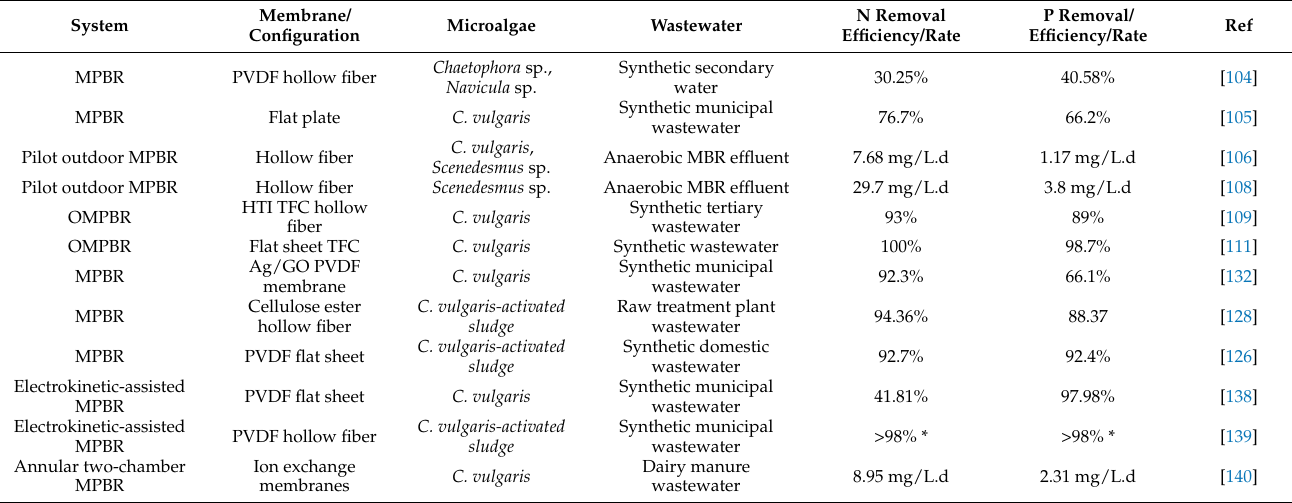
Table 1. Summary of the nutrient removal efficiencies of